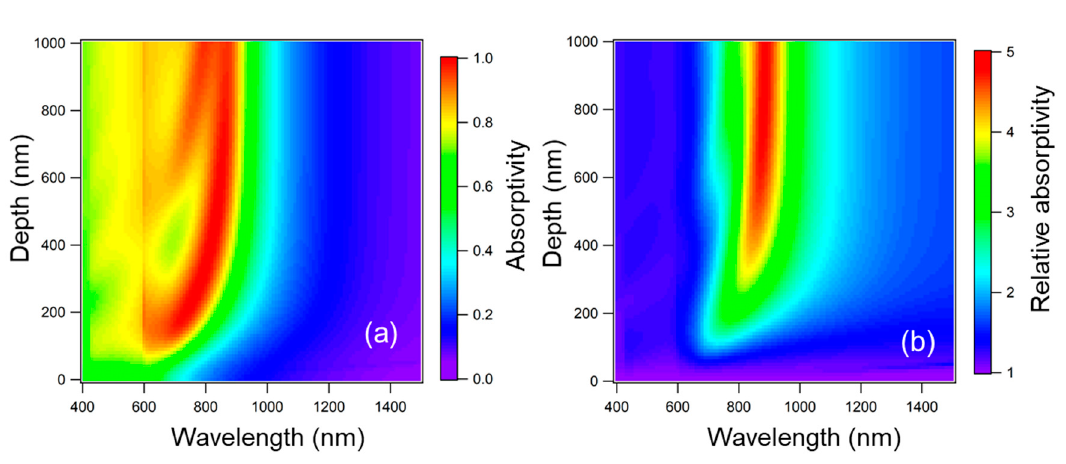
Figure 7. Simulated spectral maps: ( a ) spectral absorptivity / emissivity of a Ta microcavity metasurface to the depth of a microcavity with w = 350 nm and P = 600 nm and ( b ) relative spectral absorptivity / emissivity for the flat surface of Ta.